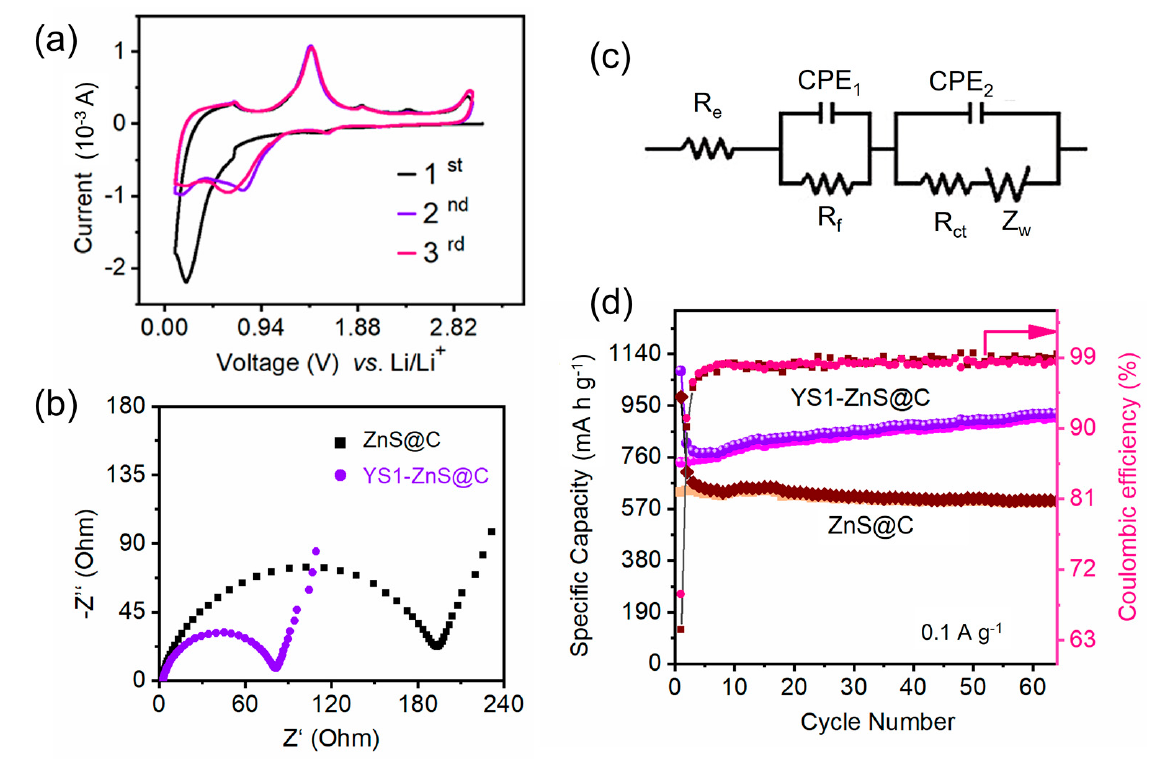
Figure 6. ( a ) Cyclic voltammogram curves of YS1-ZnS@C in the initial three cycles at 0.2 mV s − 1 between 0.1 and 3.0 V. ( b ) Nyquist plots and ( c ) the equivalent circuit model [54] of ZnS@C and YS1-ZnS@C electrodes; ( d ) Cycling performance of ZnS@C and YS1-ZnS@C electrodes in the voltage range of 0.1–3.0 V at a current density of 100 mA g − 1 .